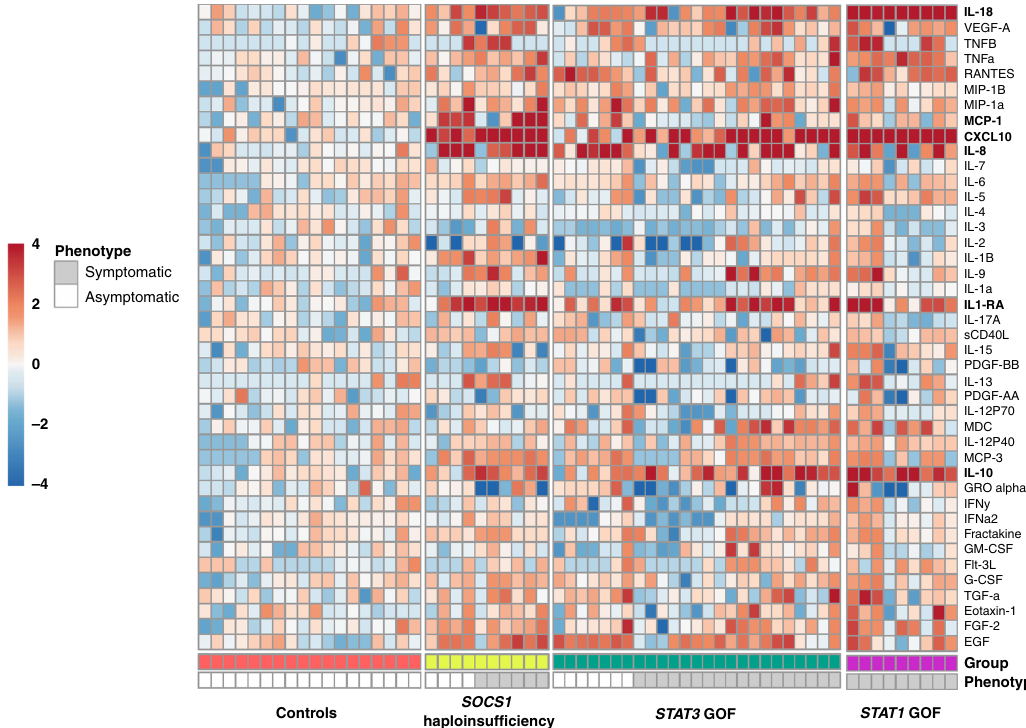
Fig. 3 In fl ammatory cytokine signature in serum from patients with SOCS1 mutations. Cytokine array analysis of serum from patients with SOCS1 insuf fi ciency, controls, patients with STAT1 GOF mutations, and patients with STAT3 GOF mutations. Gray: symptomatic patients; white: asymptomatic carriers. Decimal logarithms of the values determined in a multiplex bead assay were color-coded as follows: for each individual cytokine, median values obtained in the 17 HCs were de fi ned as 0 (white). The X-fold standard deviation above this median (0 to + 4, coded in red) or below this median (0 to − 4, coded in blue) is shown with the individual squares. The color code was arbitrarily truncated at ±4